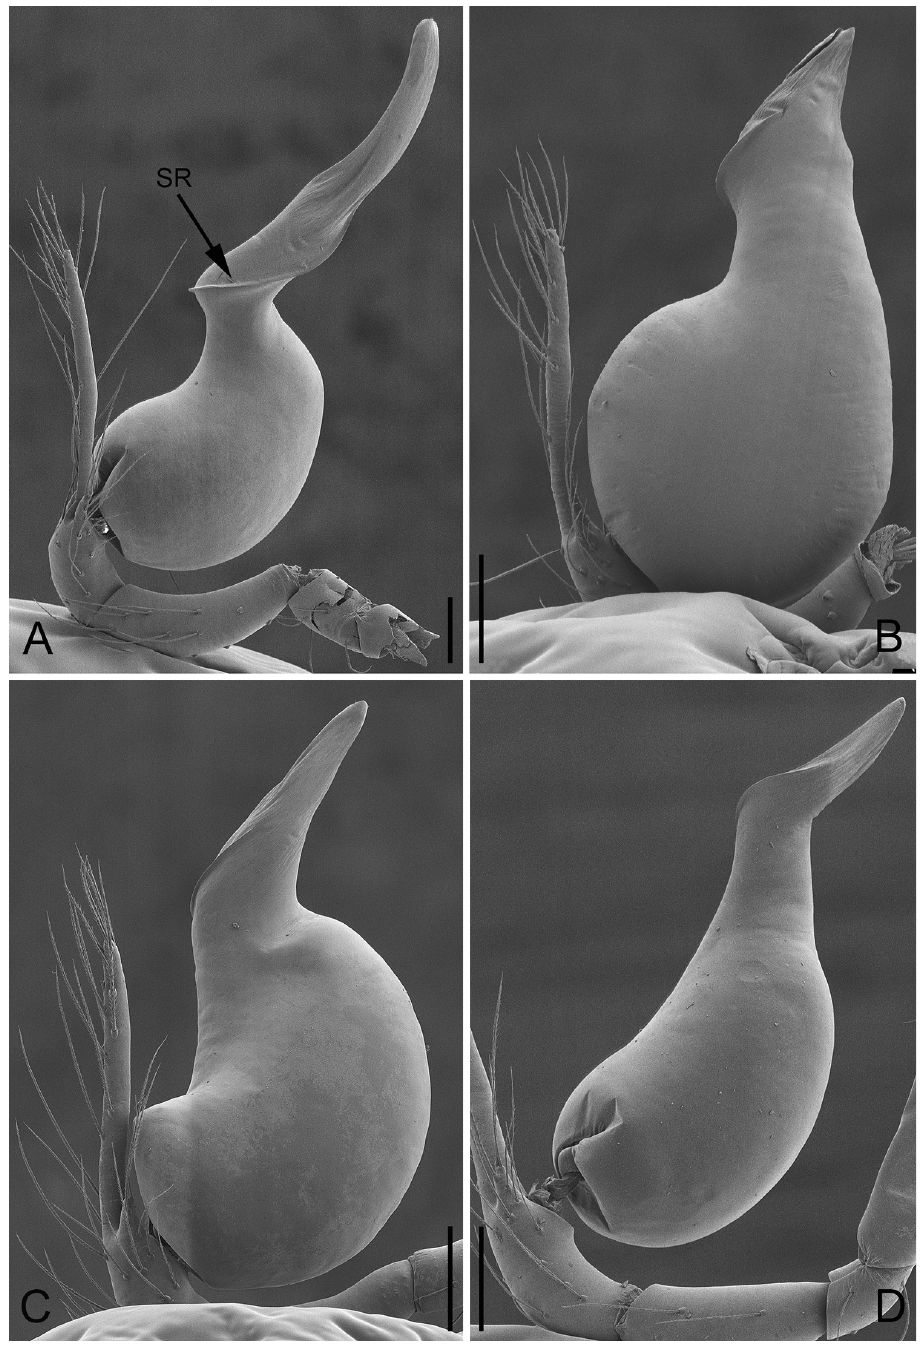
Figure 7. Prolateral view of male palp of P. bailongensis ( A ); P. cunfengensis sp. n. ( B ); P. podiensis sp. n. ( C ); P. qingfengensis sp. n. ( D ). Scale bars: 0.1